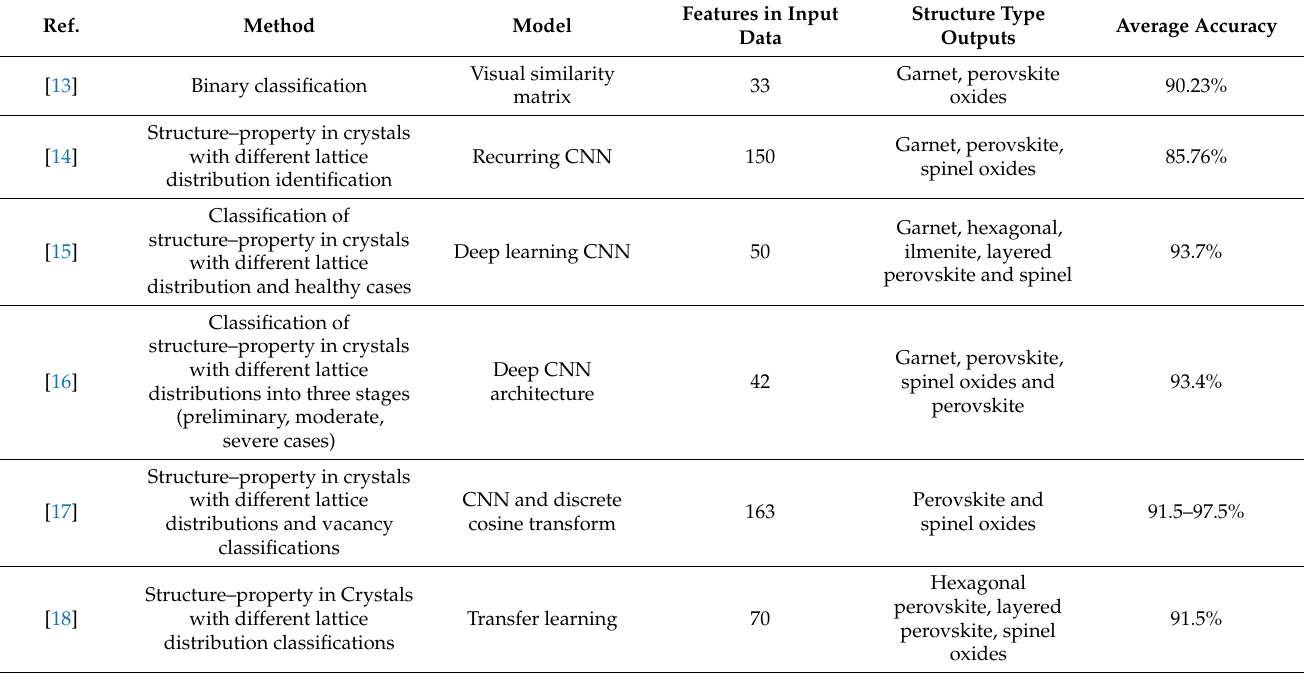
Table 1. Recent research in structure–property in crystals with different lattice distribution prediction deep learning